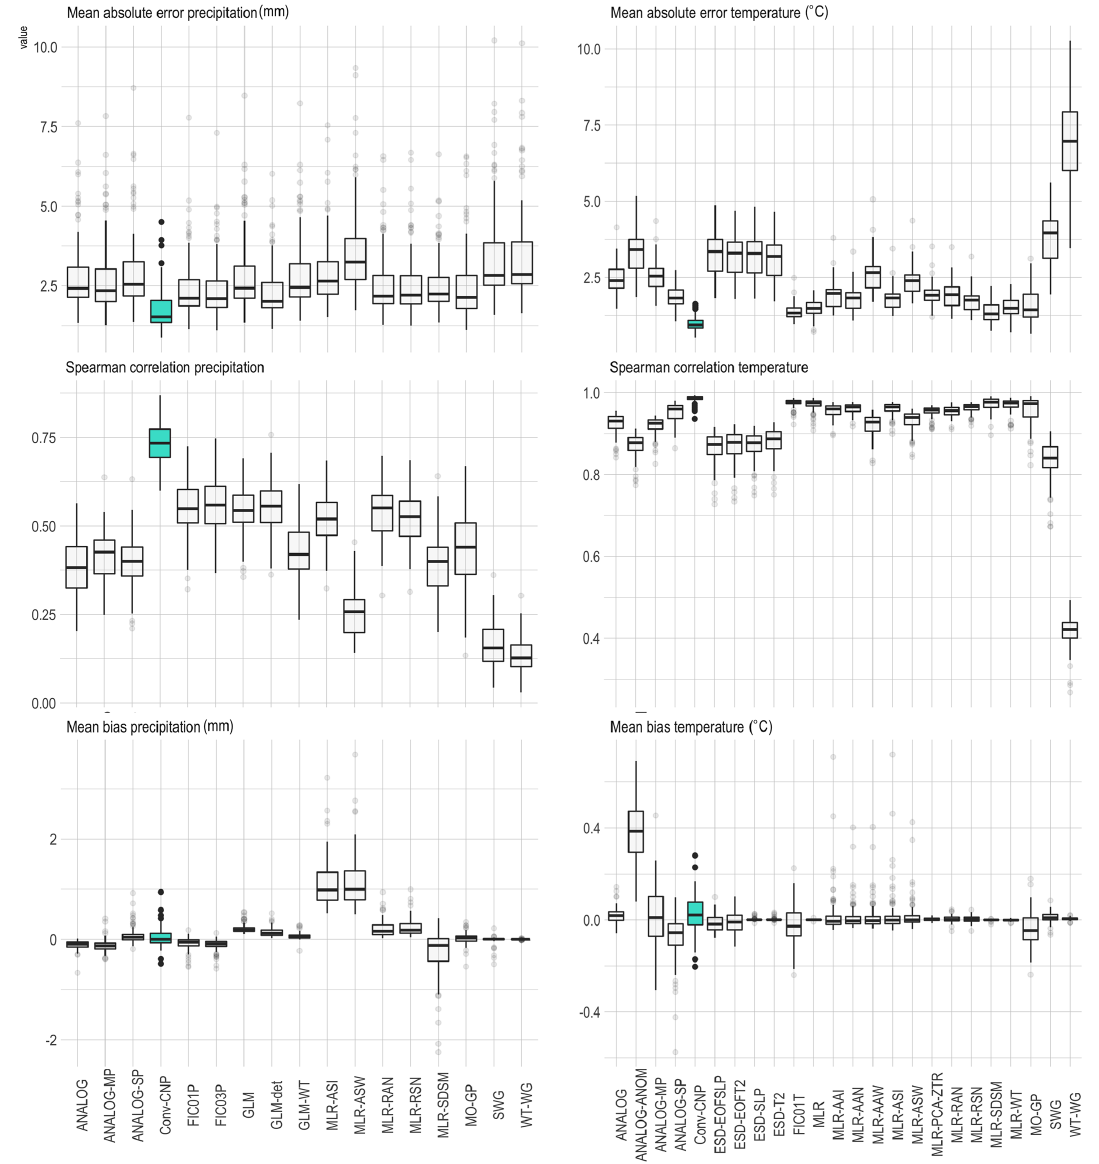
Figure 4. Comparison of the convCNP model to VALUE ensemble baselines for mean metrics, with the convCNP model shaded in blue. Each box summarises the performance for one model in the ensemble over the 86 training stations on the held-out validation